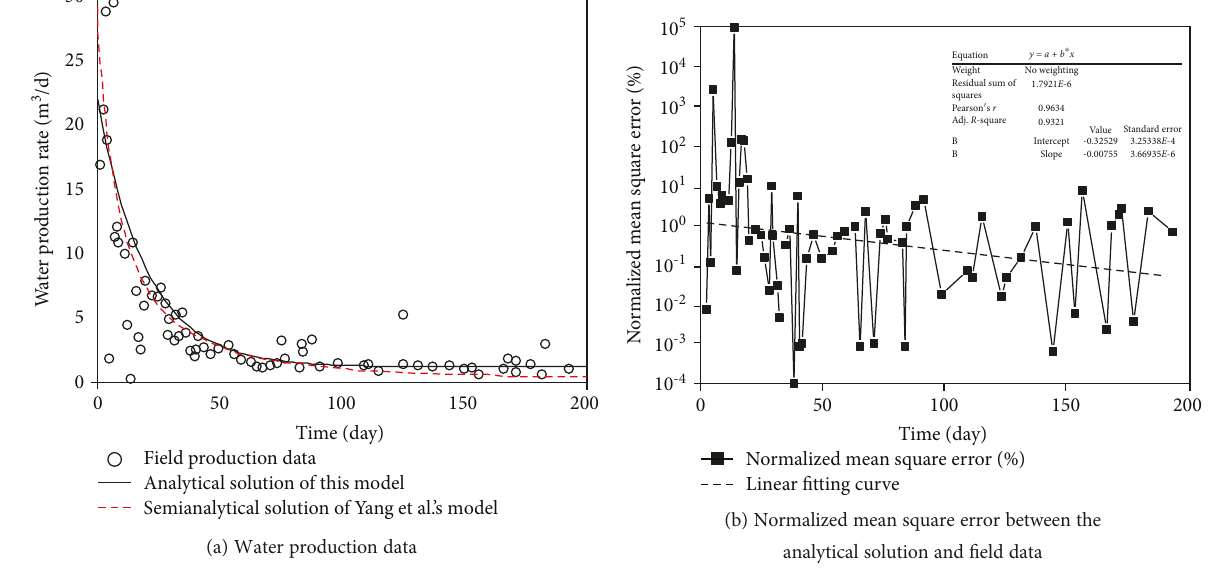
Figure 4: Model veri fi cations of water production in the fl owback period of a China shale reservoir. Table 2: Model parameters in computation for the Barnett shale gas